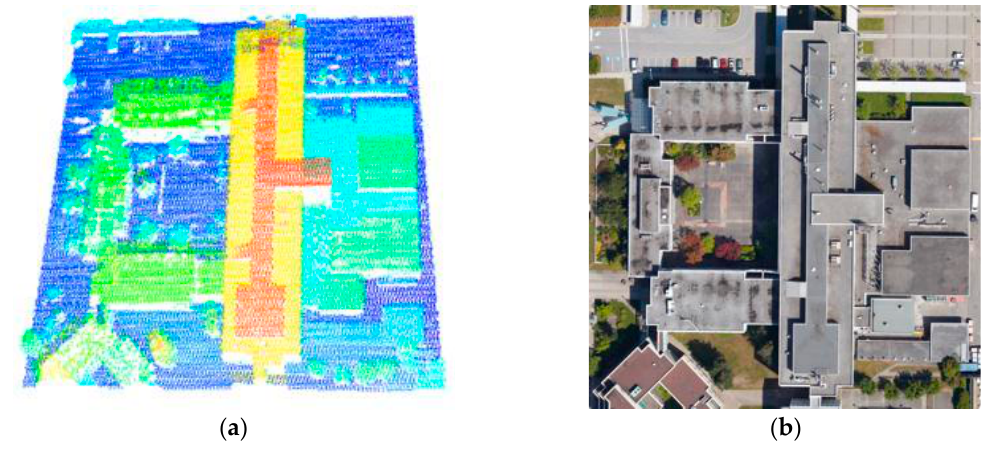
Figure 35. ( a ) Laser scanning point cloud colored according to height, and ( b ) a part of a captured image over the complex building of interest.